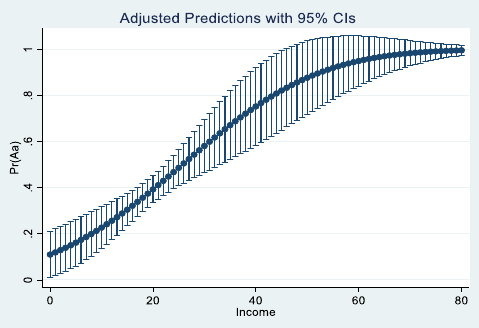
Figure 9. The non-linear impact of off-farm income on the probability to adopt a risk management strategy.